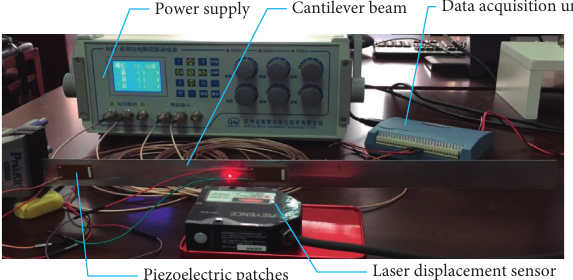
Figure 10: Experimental